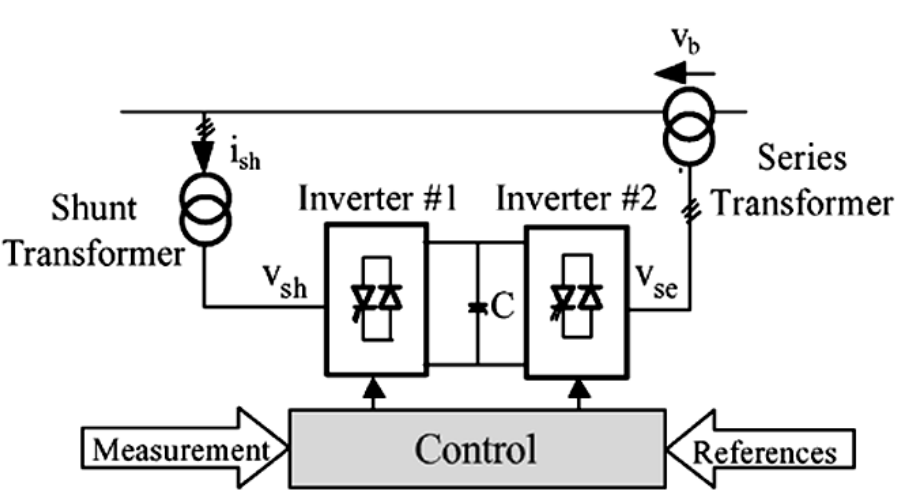
Figure 6. The basic configuration of UPFC showing principle function [58].